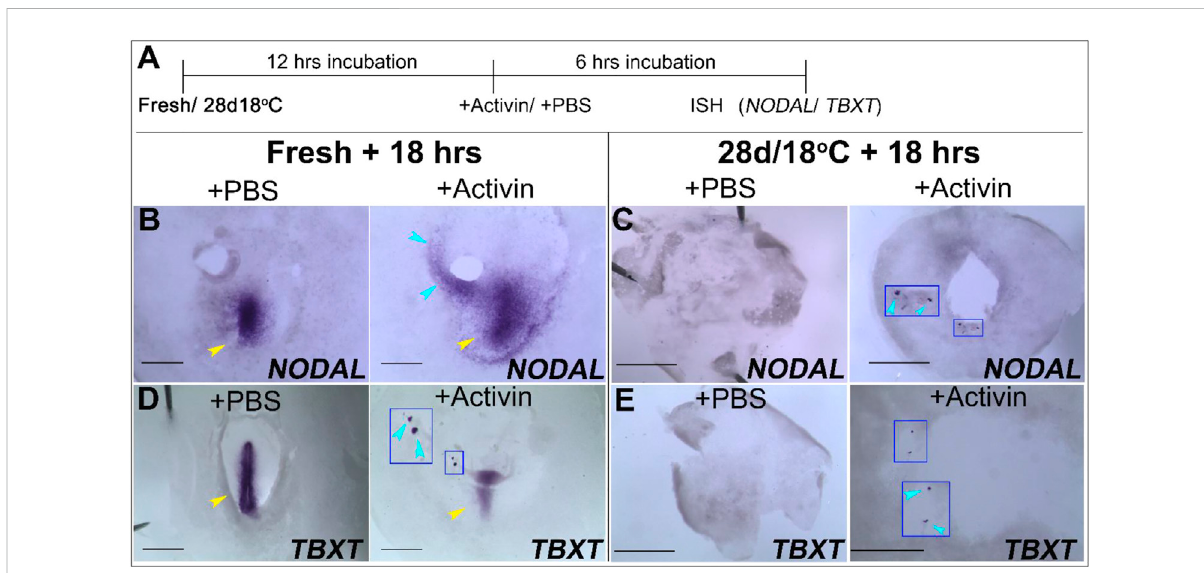
FIGURE 6 EctopicapplicationActivininducetheexpressionof NODAL and TBXT infreshand28 days/18 ° Cembryonicgroups. (A) Schematicillustrationof the experimental design. Freshly laid embryos or 28 days/18 ° C stored embryos were incubated for 12 h at 37.8 ° C and then treated with PBS- or Activin-soaked bead for 6 h. Embryos were analyzed for NODAL and TBXT expression by WMISH. (B , D) WMISH analysis of NODAL and TBXT expression in fresh embryos following treatment with PBS or Activin protein. While the mock control fresh embryo treated with PBS-soaked beads expressed NODAL and TBXT gene in PS region only (yellow arrowhead, n = 4/4; 4/4, respectively), transplanting Activin-soaked beads in embryos, induced NODAL and TBXT expression near the transplanted beads (blue arrowhead, n = 4/4; 3/4, respectively, inset in D shows induced TBXT gene expression in high magni fi cation view) as well as its normal expression in PS region (yellow arrowhead). ( C , E ) WMISH analysis of NODAL and TBXT expression in 28 days/18 ° C embryos following treatment with PBS or Activin protein. While in control embryos no NODAL and TBXT expression was induced ( n = 4/4; 3/3, respectively), in Activin-treated embryos NODAL and TBXT expression were evident in the vicinity of the implanted beads ( C , E , n = 5/5; 5/7, respectively; insets in C , E and blue arrowheads show induced NODAL and TBXT gene expression in high magni fi cation view). Bar = 1